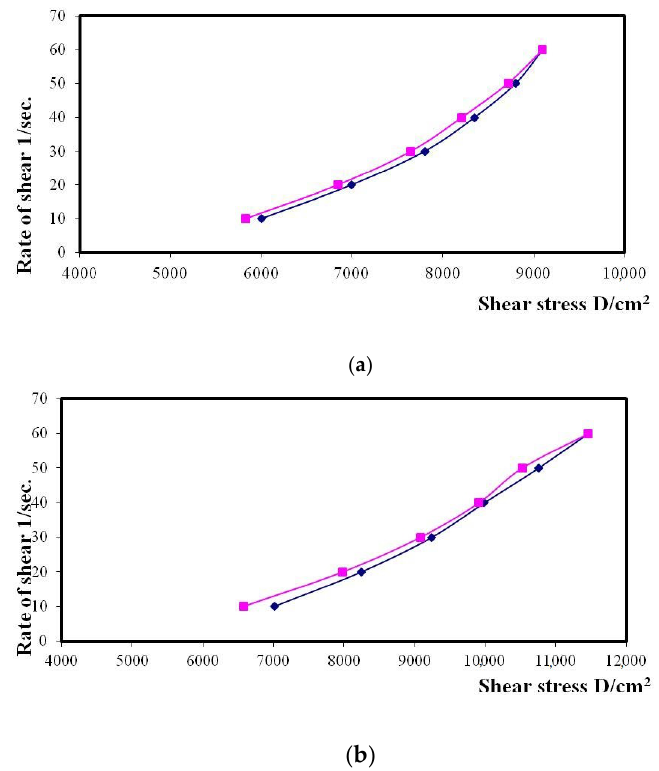
Figure 6. Rheogram of the ( a ) blank hyaluronic acid hydrogel and ( b ) HA-FS-NTF. Values calculated by the Farrow’s constant (N) indicate a deviation in the fluid of the Newtonian flow behavior, where an increased value indicates a change in the flow behav- ior toward a more non-Newtonian flow [34]. Calculations for the values of the Farrow’s constant (N) were performed by plotting the logarithm of the shear rate (G) versus the logarithm of the shear stress (F), where the slope indicates the value of N (Figure 7). A value of less than 1 indicates dilatancy, and a value greater than 1 indicates pseudoplastic flow [34]. The flow behavior of the formulated hydrogels is presented in Table 8. All the hydrogel formulations had thixotropic behavior with pseudoplastic flow, and that is a desirable property for pharmaceutical gels for oral use. This special flow characteristic of hyaluronic acid hydrogel could be due to the breakdown of the structural configuration through the interruption of the existing intermolecular interactions between polymeric chains upon application of shear. There is further reoccurrence of polymerization between the molecules due to the force of the van der Waals interaction between the molecules upon removal of such shear [35,36]. The present study outcomes indicate that the optimal formulation of the HA-FS-NTF could facilitate the mean residence time within the oral cavity. This attribute is mostly due to the greater affinity of hyaluronic acid for the oral membrane due to its viscosity.